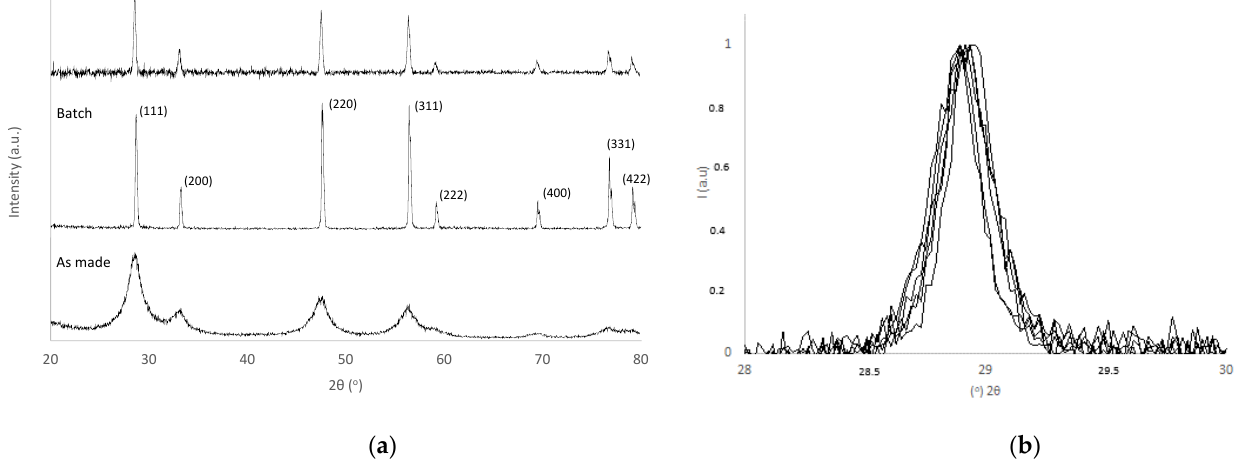
Figure 1. XRD studies. ( a ) XRD of B11M, with the hkl index of each plane indicated between brackets; ( b ) detailed XRD 111 peak of the six batch materials (BXXX) prepared under batch conditions, with the peaks normalized for comparison purposes.